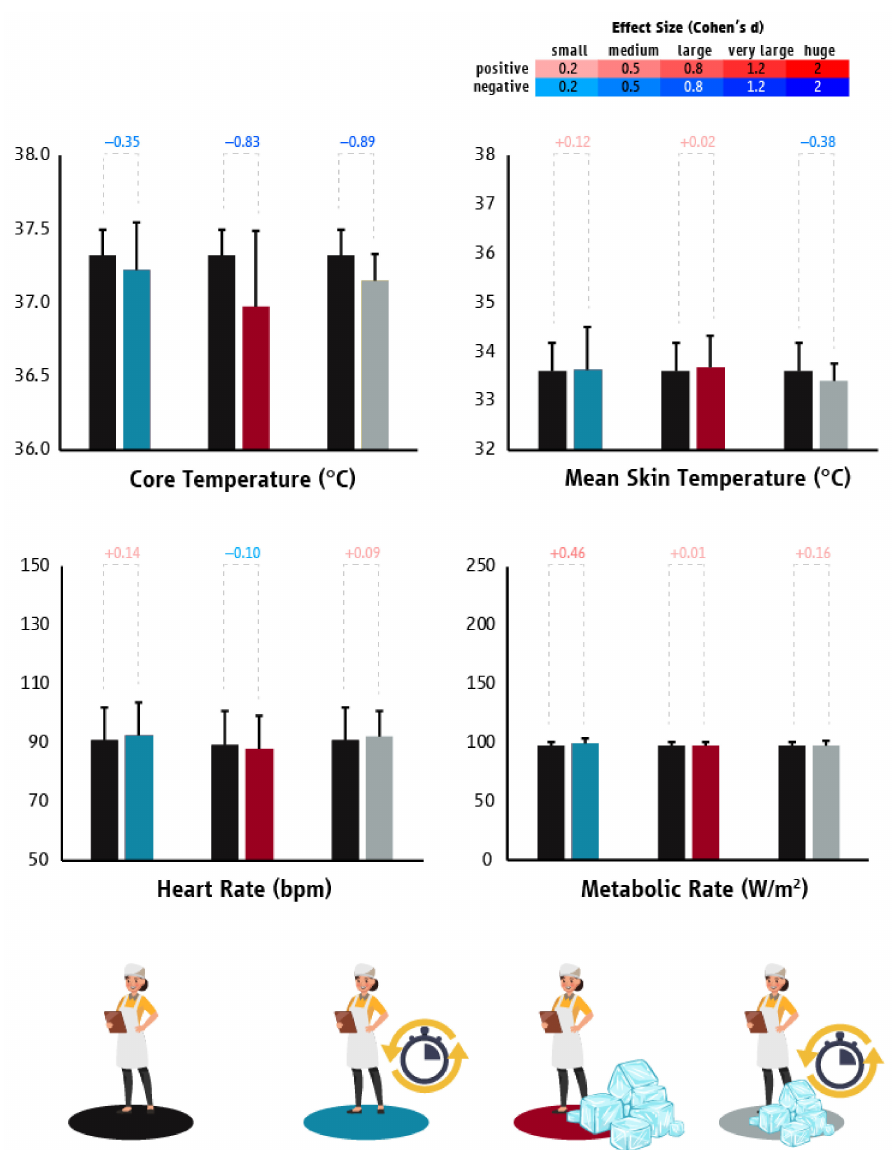
Figure 9. Differences (mean ± SD) in core temperature, mean skin temperature, heart rate, and metabolic rate/work intensity between “business as usual” and the tested heat mitigation strategies in the tourism sector of Greece. Black, light blue, red, and grey colors represent “business as usual”, planned breaks, ice slurry, and “combined” (two minutes of planned break combined with ice slurry consumption (2.4 g per body mass kilogram) every hour of continuous work) scenarios, respectively. Cohen’s d effect sizes show the magnitude (small: 0.2; medium: 0.5; large: 0.8; very large: 1.2; huge: 2.0) and direction (positive: shades of red; negative: shades of blue) of the differences between “business as usual” and the tested heat mitigation